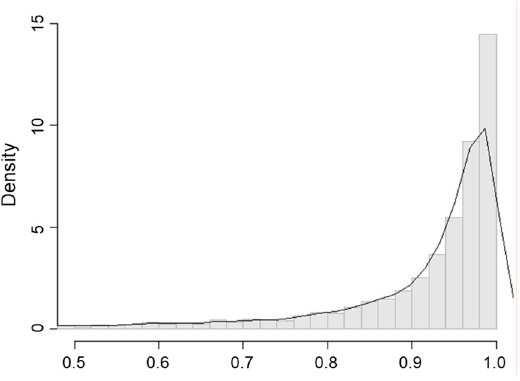
Figure 2. Distribution of Salmonella concentration (CFU/g) on raw pork after washing twice.